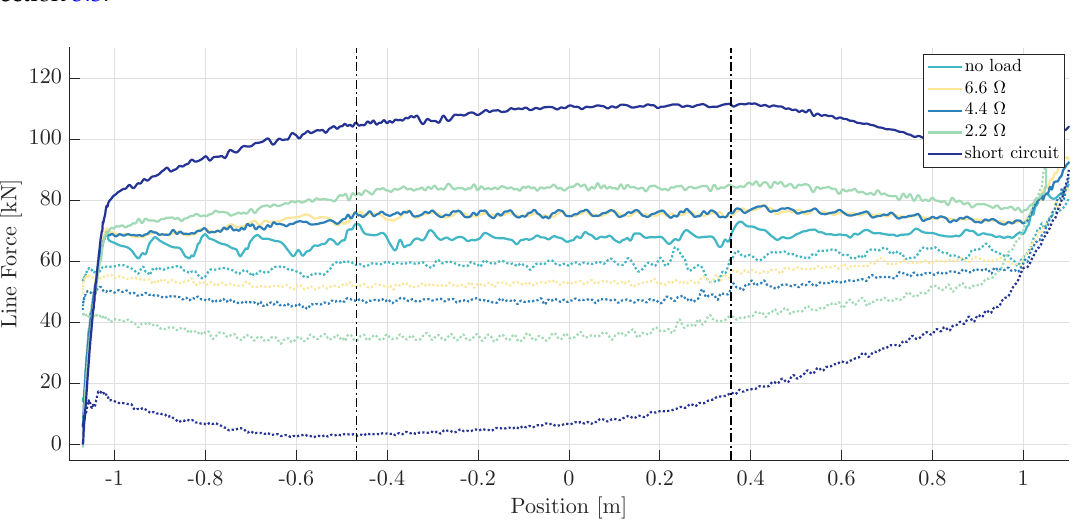
Figure 5. Line force in position domain for the low speed tests. Upward motion is represented with solid lines and downward motion is represented with dotted lines. The full active area is marked by vertical dotted lines.